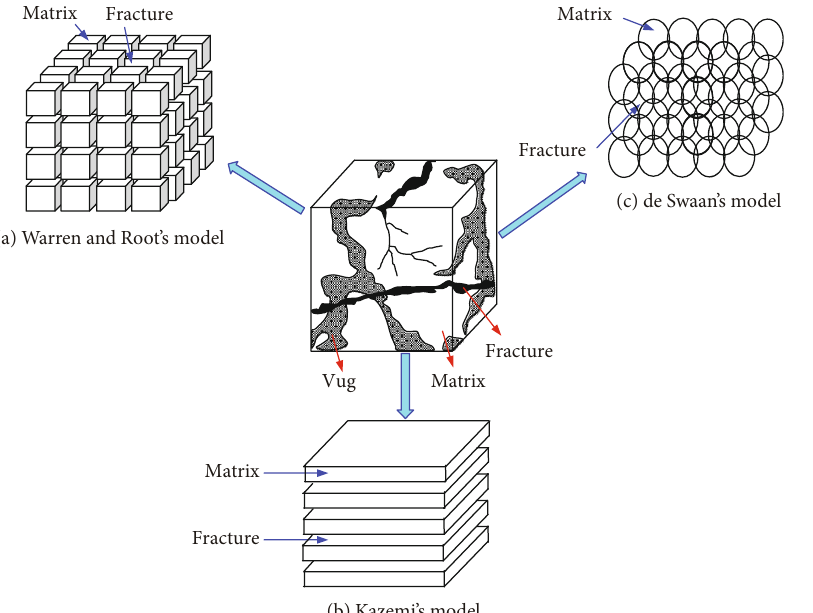
Figure 9: Conceptual model for dual-porosity formation [58 – 60,